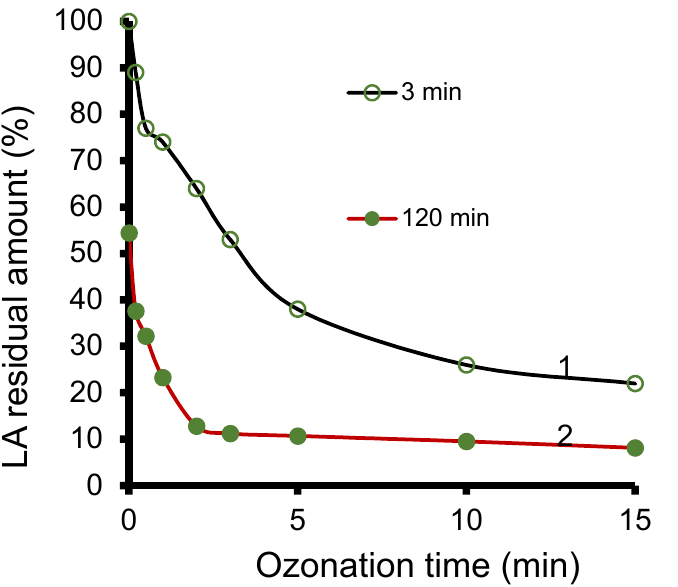
Figure 6. LA residual amount (%) during ozonation of Ht suspension after 3 min contact time under mild manual stirring (1) and 120 min under vigorous magnetic stirring (2). LA residual amount (LARA) was assessed with HPLC-UV in the centrifuged supernatant after 40 mg hydrotalcite immersion in 20 mL LA aqueous solution with a concentration of 2.5 g.L − 1 (27.75 mM).